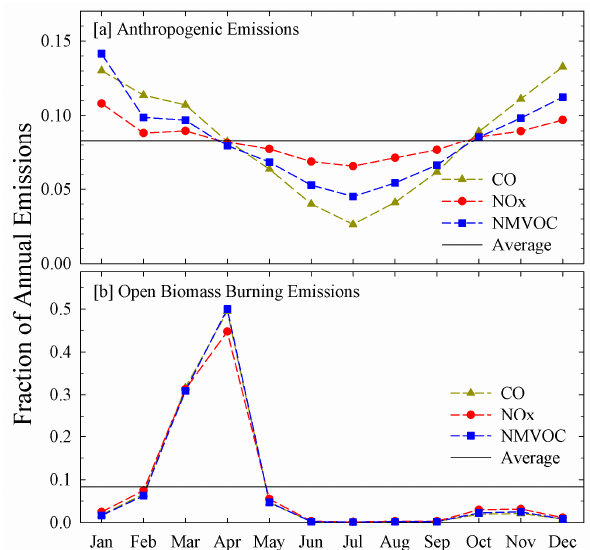
Fig. 2. Seasonal variations in domain-wide (a) anthropogenic and Figure 2: Seasonal variations in domain-wide (a) anthropogenic and (b) open biomass burning 1274 (b) open biomass burning emissions of CO, NO x and non-methane emissions of CO, NO x and non-methane volatile organic compounds (NMVOCs) used by the 1275 volatile organic compounds (NMVOCs) used by the model. The model. The black solid line represents annual average emission. 1276 black solid line represents annual average